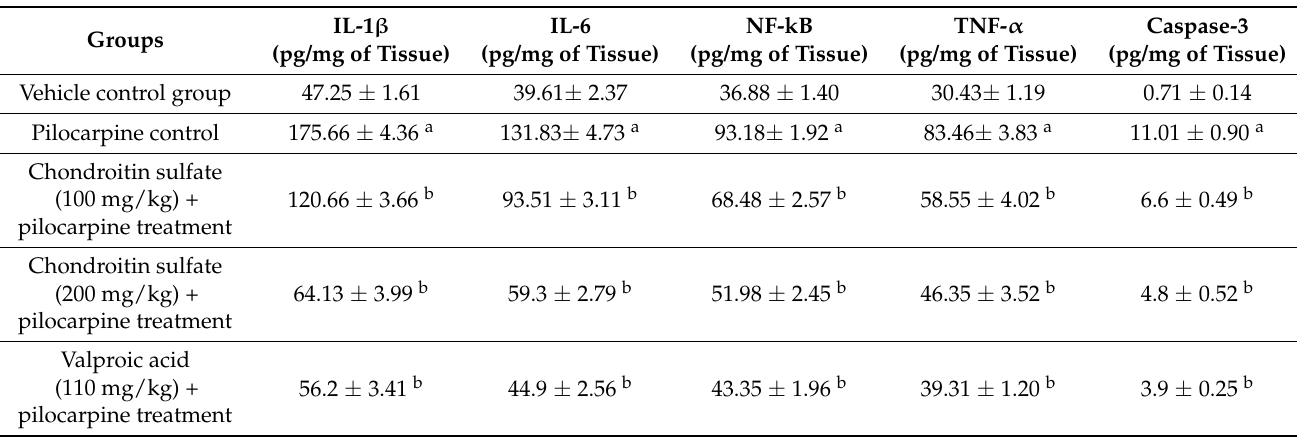
Table 4. Neuroprotective chondroitin sulfate on IL-1 β , IL-6, NF-kB, TNF- α , and caspase-3 concentration in pilocarpine- induced spontaneous seizures in mice. Values are expressed as mean ± S.D.; a p < 0.01 vs. vehicle control; b p < 0.05 vs. PC